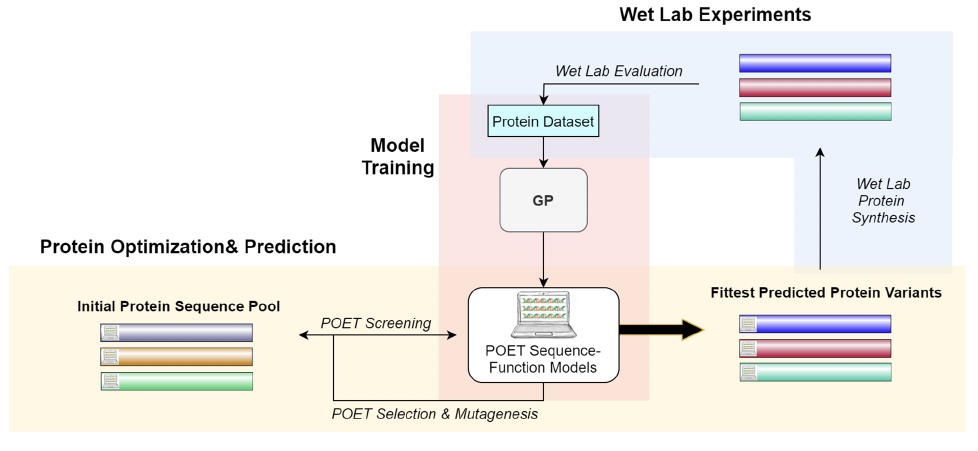
Figure 2 A high-level overview of POET. POET starts with training its sequence-function models using a curated dataset of protein sequences and their respective CEST contrast values (Model Training). Pro- tein Optimization evolves a random pool of protein sequences to predict fitter variants by using previously trained models for evaluation. Different colors for protein sequences indicate that POET can start from a random pool and is able to find fitter proteins in a different search space from the starting pool. Pre- dicted variants are evaluated in wet labs, and their measured values are added back to the protein dataset to evolve fitter CEST predicting models. The small computer sign on the left side of the proteins differen- tiates between natural and computational protein sequences. Full-size DOI: